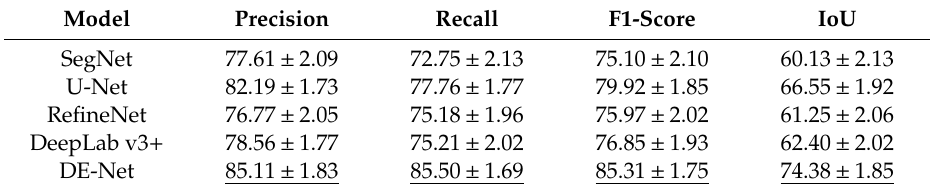
Table 2. Quantitative evaluation results on the testing set of the Suzhou building dataset (Suzhou dataset) by di ff erent models in terms of precision (%), recall (%), F1-Score (%), and IoU (%) (the best values are underlined).